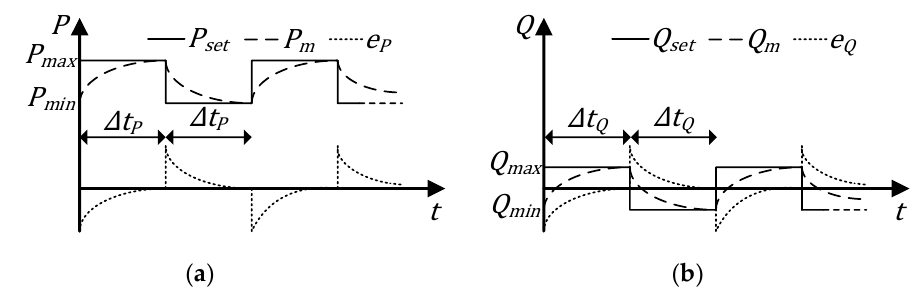
Figure 3. Controller disturbance pattern: ( a ) active power, ( b ) reactive power.